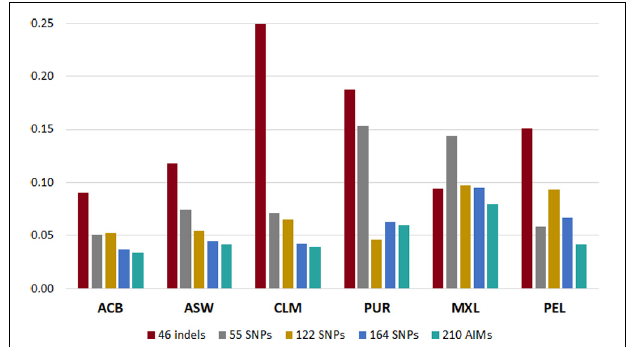
FIGURE 6 | Sum of deviations from the reference values (Martin et al., 2017) reported by each panel in the six admixed American populations from the 1000 Genomes database.